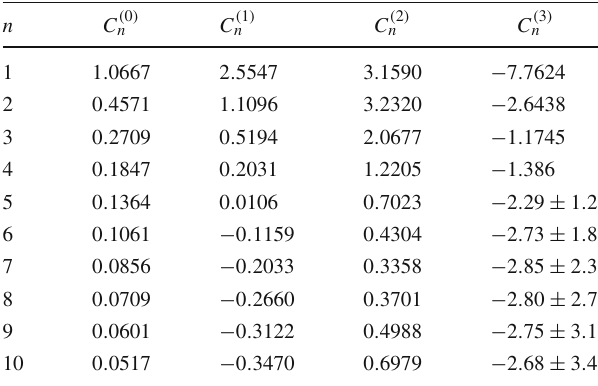
Table 1 Coefficients C ( i ) n for the perturbative expansion of the QCD moments entering Eq. (7). The values quoted with an uncertainty are taken from Ref. [23]